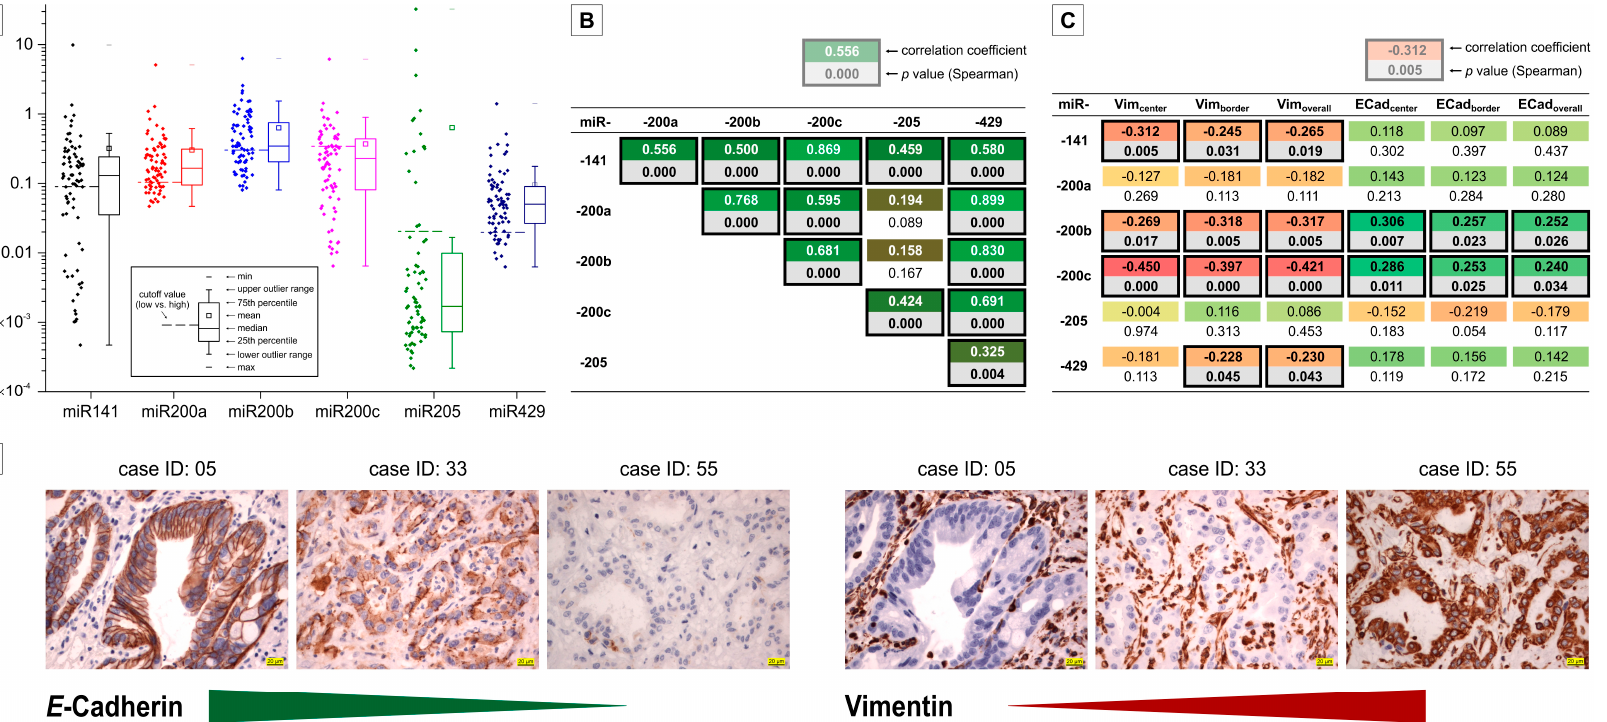
Figure 2. Expression of miR200 family members, miR205 and EMT markers E -cadherin and vimentin in clinical BTC samples. ( A ) Relative expression (to reference miRs RNU6 and SNORD61) of miR200 family members and miR205 in n = 78 BTC cases (formalin-fixed paraffin-embedded material); ( B ) Spearman correlation analysis of miR expression levels in BTC cases. The first numeric value in each analysis (rectangle) represents the correlation-coefficient (ranging from green for positive correlation to red for negative correlation), the second represents the p -value (highlighted grey when significant). Significant correlations are highlighted by a black border; ( C ) Spearman correlation analysis of miR expression levels and vimentin, respectively, and E -cadherin expression patterns in BTC cases; and ( D ) representative immunohistochemistry images of three BTC cases exemplifying inverse expression patterns of E -cadherin and vimentin. Scale bar ( yellow ) indicates 20 µm. Abbreviations: BTC: Biliary tract cancer; Ecad: E -Cadherin; EMT: Epithelial to mesenchymal transition; miR: MicroRNA; Vim: Vimentin.